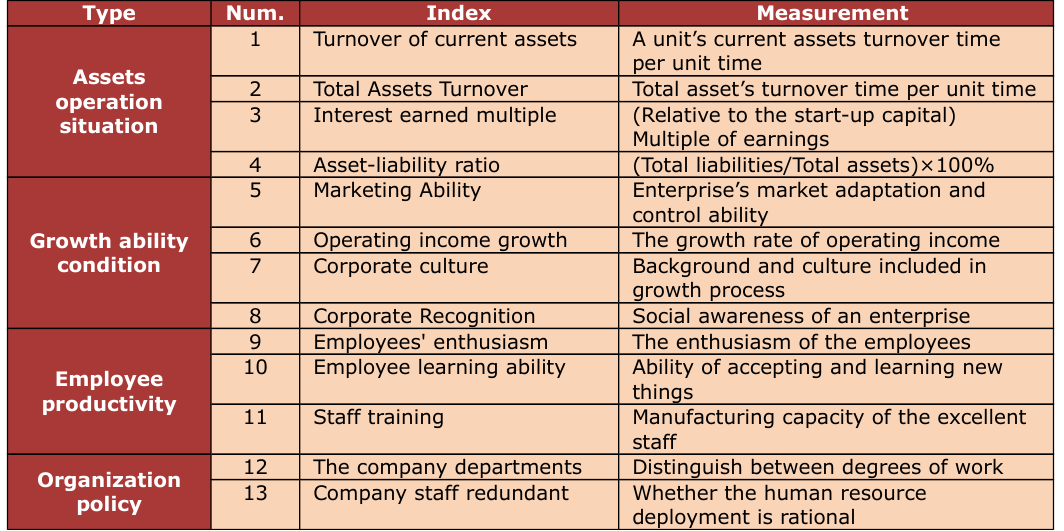
Table 1. Primary indexes of enterprise performance